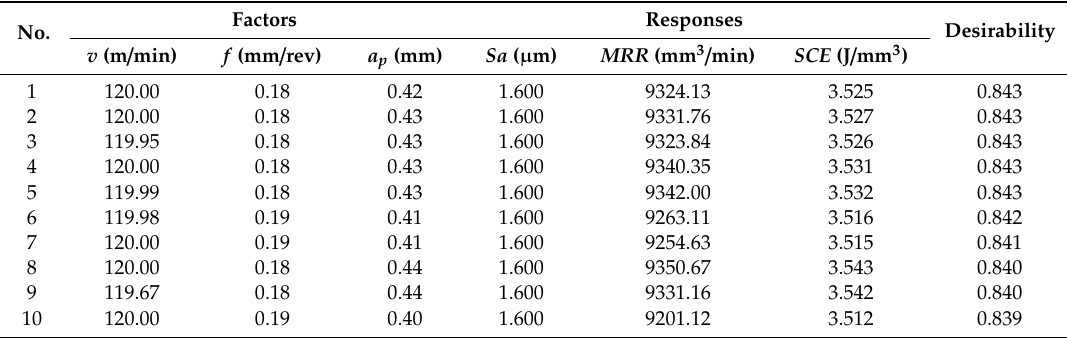
Table 6. Solutions of numerical